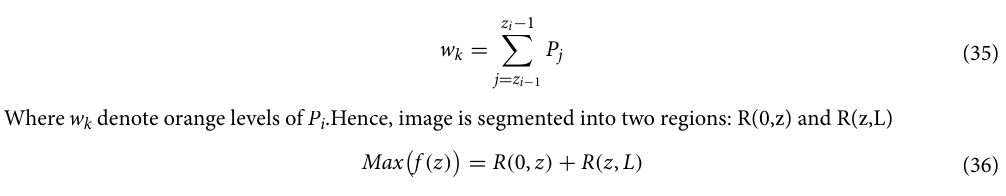
Figure 6. Performance graphs of Optimizers on hybrid test